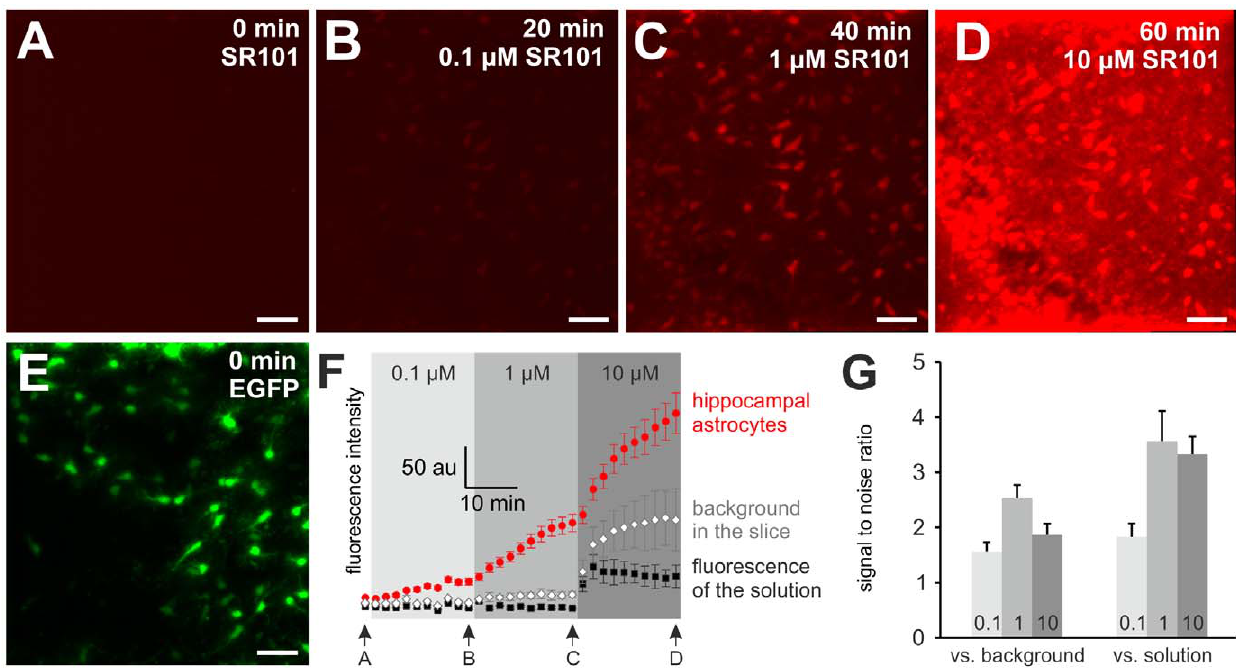
Figure 5. Accumulation of SR101 in cells. A–D: Maximum intensity projections of 2-photon z-stacks from time-lapse recordings during the staining of hippocampal CA1 region with different SR101-concentrations (70 m m z-stacks, 2 m m steps, 2 min 2 1 ). A: SR101-fluorescence before SR101 was applied. B–D: SR101-fluorescence at different time points as indicated. E: EGFP-fluorescence of the astrocytes. Scale bars: 40 m m. F: Quantitative analysis of the time course of the SR101- fluorescence in hippocampal astrocytes (n=17 astrocytes, 3 slices, red circles) and SR101-intensity of the background within the slice (n=3 spots) and in the SR101 containing aCSF solution above the slice (n=3 spots). G: Comparison of signal to noise ratio of the somatic SR101-fluorescence of astrocytes versus background (in the slice) and versus the SR101 in the aCSF solution above the slice. Note: 1 m M SR101 gave the best signal to noise ration.